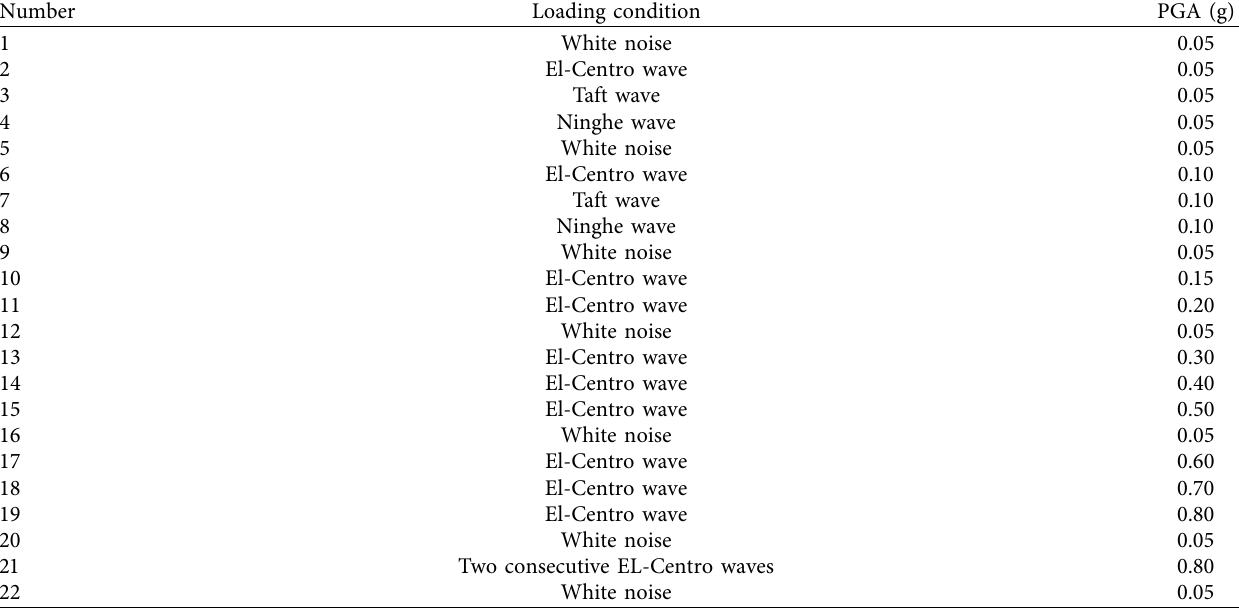
Table 4: Loading procedure.